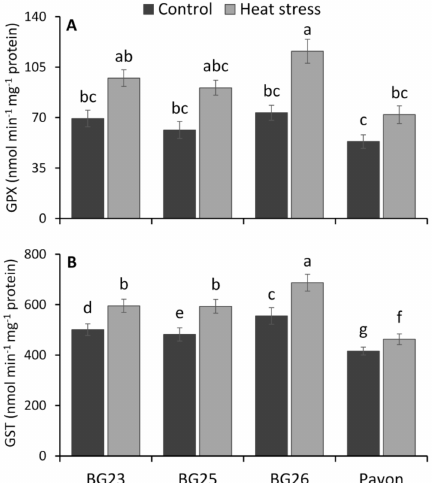
Figure 6. The specific activity of ( A ) glutathione peroxidase (GPX) and ( B ) glutathione-S-transferase (GST) enzymes of wheat varieties under control and heat-stressed conditions. Vertical bars represent +/ − SE values. Different letter(s) indicate significant difference at p <